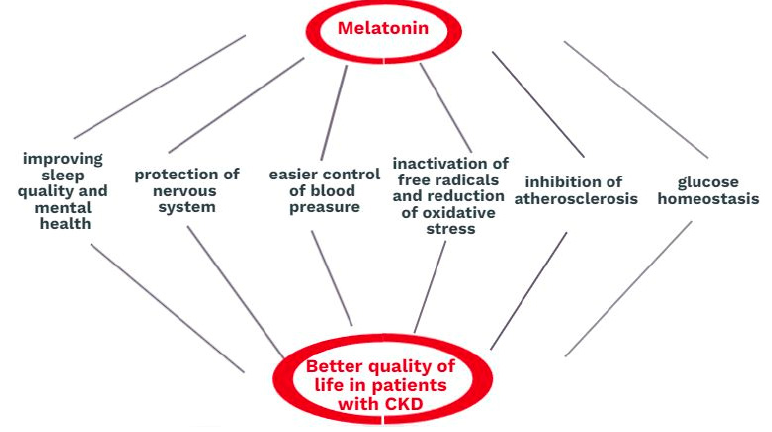
Figure 3. The role of melatonin in kidney diseases. So far, there have been many studies of exogenous melatonin administration to animals. However, the number of human studies with the use of melatonin is not high, but it is increasing. According to the available clinic trials, melatonin can improve the quality of life and prolong survival in patients with CKD.